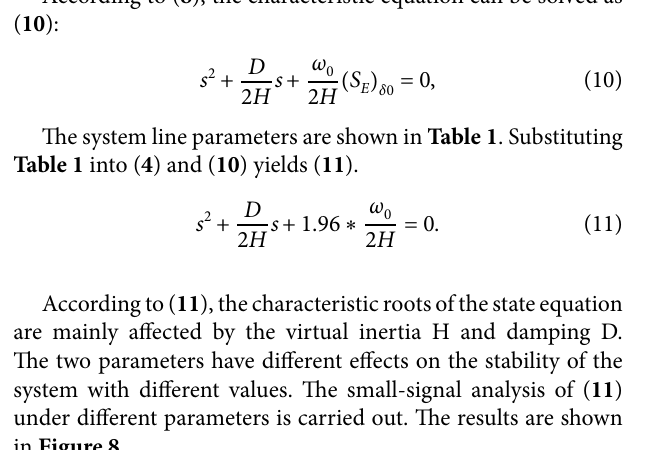
In Figure 6 , Z and Z are characteristic lines with the same 1 2 line impedance and same length.